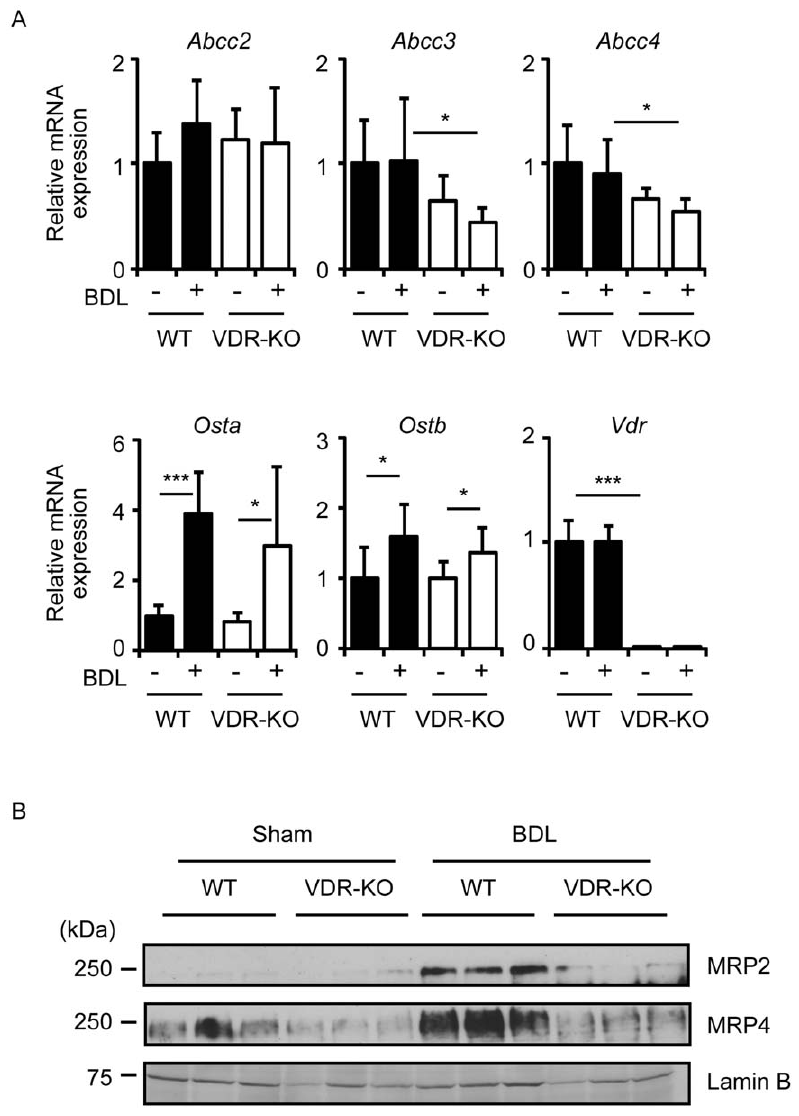
Figure 3. Renal mRNA and protein expression of bile acid and bilirubin transporters. (A) mRNA expression of transporters. Total RNAs were prepared from the liver of wild-type mice (WT) and VDR-null mice (VDR-KO) 7 days after sham operation or BDL. Vdr mRNA expression was not observed in the kidney of VDR-null mice. The values represent means 6 S.D. * p , 0.05; *** p , 0.001. (B) Protein expression of MRP2 and MRP4. Renal proteins from the kidney of mice 3 days after surgery were subjected to immunoblotting for MRP2, MRP4 and lamin B. Each lane was loaded with 20 m g and 40 m g of membrane proteins for MRP2/4 and lamin B, respectively.